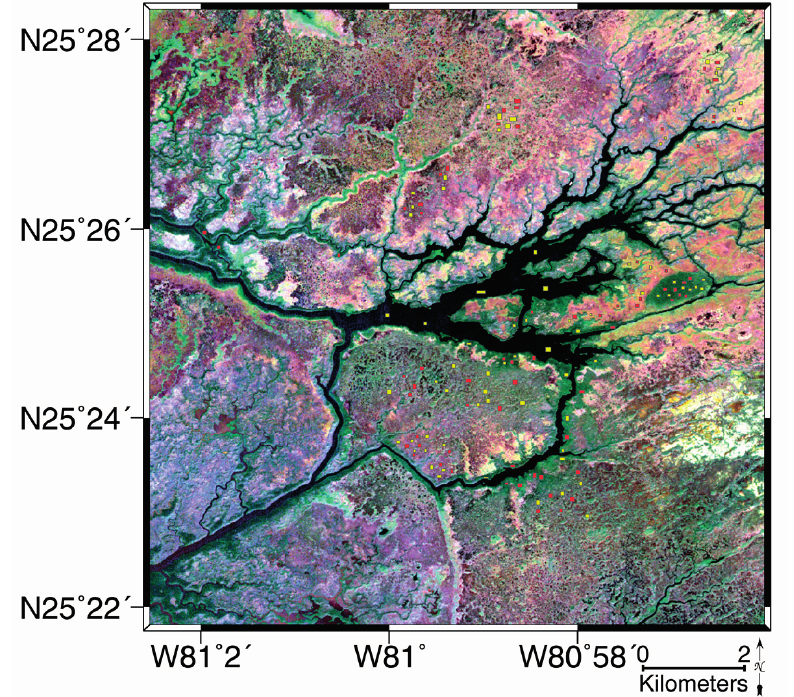
Figure 5. Field sample sites for training (red) and reference (yellow) shown on the RapidEye image (true-color combination using red, green, and blue visible